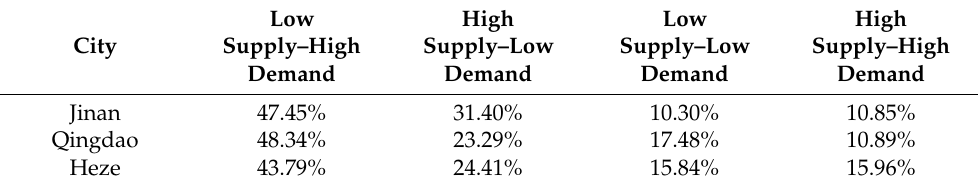
Figure 6. CIS and CID supply and demand matching quadrant division: ( a ) Jinan, ( b ) Qingdao, and ( c ) Heze. Table 4. CIS and CID match type ratio statistics.